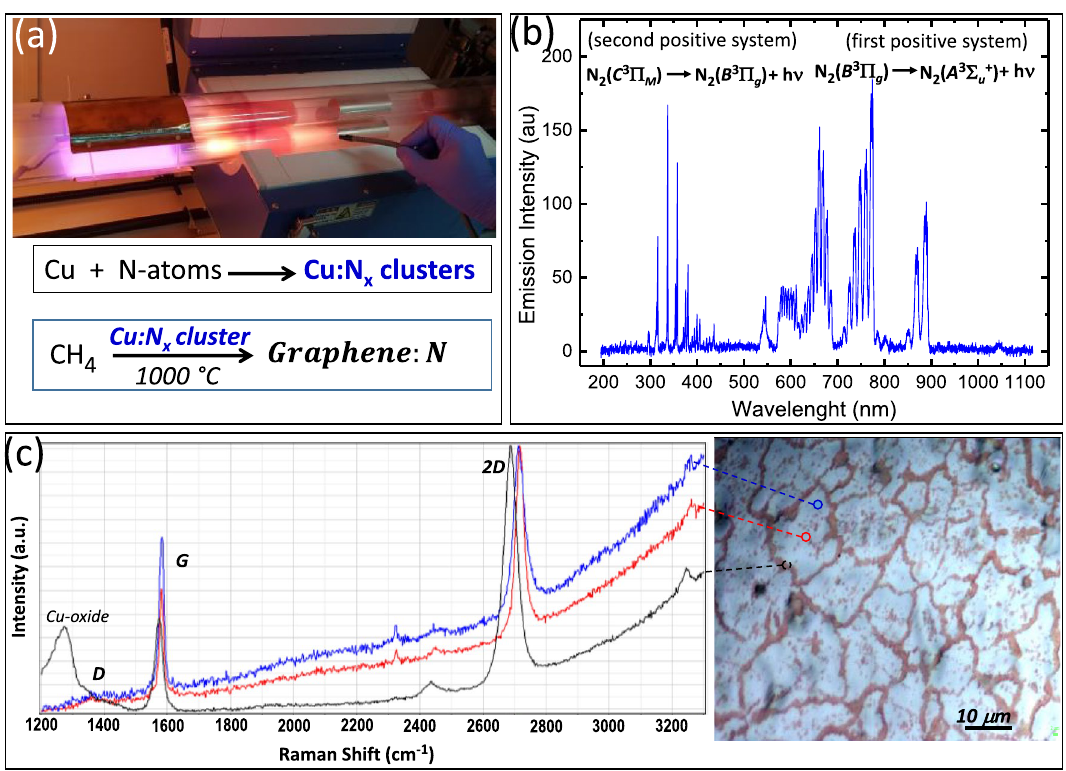
Figure 2. Growth of nitrogen doped graphene (G:N). ( a ) Image of the discharge plasma glow in nitrogen for copper nitridation and schematic of the graphene:N growth process using the Cu:Nx cluster (nitrogen solid source) in-situ prepared before growth. ( b ) Optical emission spectroscopy of the active species in the downstream of the N 2 plasma. The emission intensity of first positive system (600–900 nm) is a measure of the N-atoms. ( c ) Raman spectra and optical microscopy of G:N on copper foil. The microscopy image shows the edge of the graphene grain as decorated (the dark line) by the copper oxide after long time exposure of the graphene covered copper foil to wet-air. The Raman spectra are collected from three different positions of the single grain: at the grain boundary (the black line), thus evidencing the copper oxide and within the grain for the wide single layer region (the blue line) and for the small bilayer island at the centre of the grain (the red